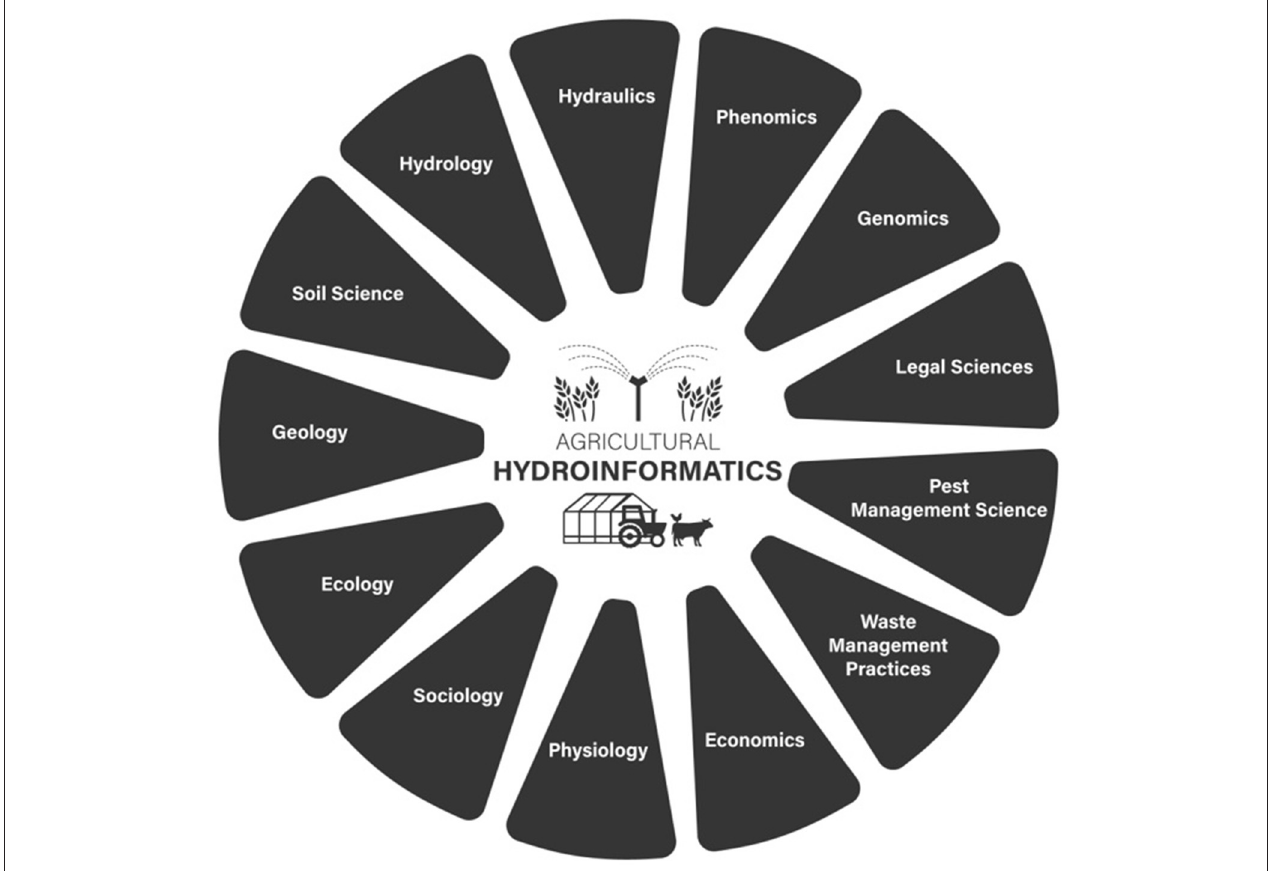
FIGURE 1 | Agricultural hydroinformatics and interacting entities as a conceptual framework.